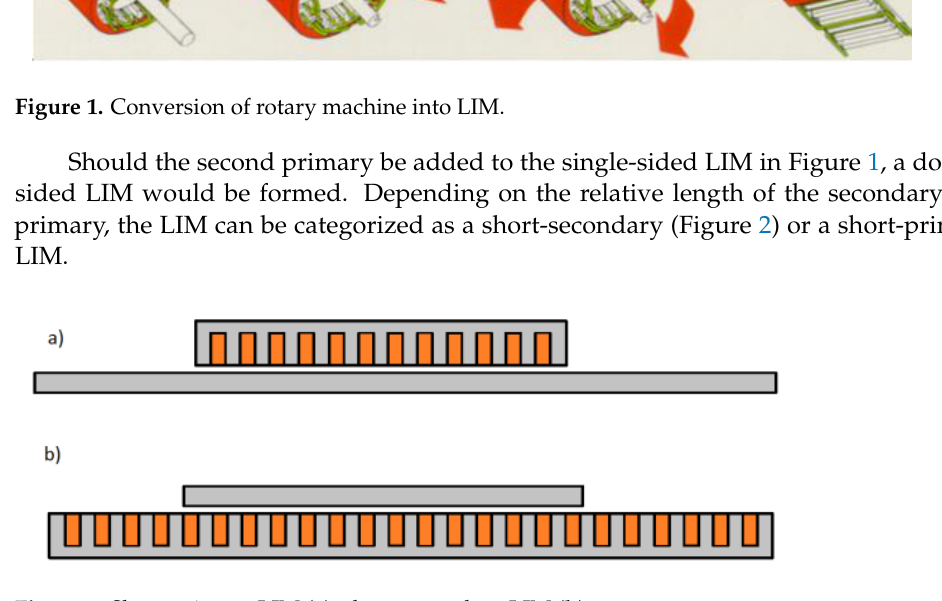
Figure 2. Short-primary LIM ( a ); short-secondary LIM ( b ). The rotary motor can be thought of as “infinite” in that its primary winding generated magnetic field is continuous and has no beginning or end around its circumference. Unlike the rotary, the short-primary LIM has a finite length. Thus, only the part of the secondary side that is immediately below the primary is subjected to a primary generated magnetic field. During motion, the new unexcited parts of the secondary side equivalent “rotor” continually enter under the LIM primary magnetic field generated by a distributed Magne- tomotive Force (MMF). This process generates a continuous electromagnetic response in the new incoming segments of the secondary, the Reaction Rail (RR), in a form of induced MMF, thereby resisting the immediate establishment of the magnetic flux under the front end of the LIM primary. Subsequently, the reaction rail MMF decays but at a lower rate dictated by the “rotor time constant” of the motor. Figure 3a shows a short-primary LIM, and Figure 3b shows the reaction rail. The RR consists of a series of aluminum top